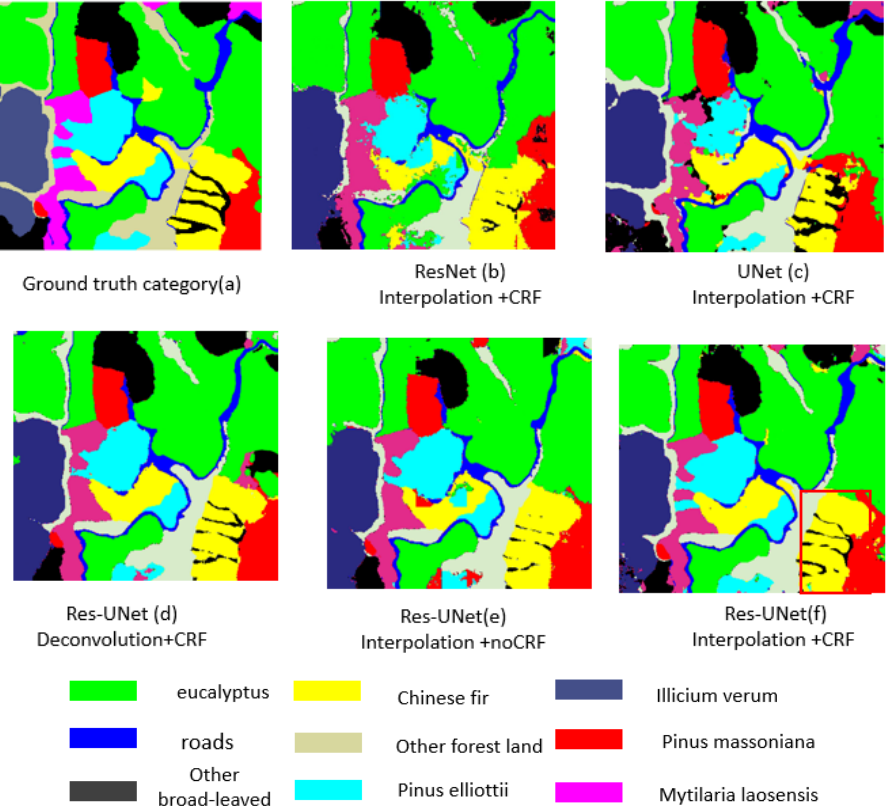
Figure 7. Tree species classification results by di ff erent classification methods. ( a ) Ground truth